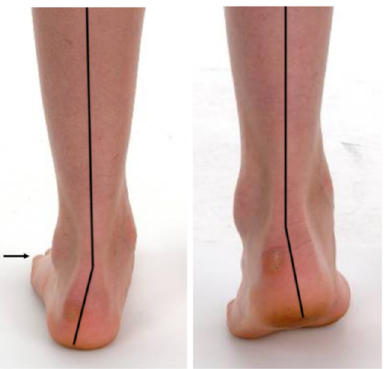
Figure 3. Functional assessment of the flexibility of the foot deformity. Hindfoot valgus and forefoot abduction ( ➔ positive “too many toes-sign”) ( left ). Complete active correction of the hindfoot valgus showing restored heel inversion ( right ) (same patient as shown in Figures 2, 4 and 5).